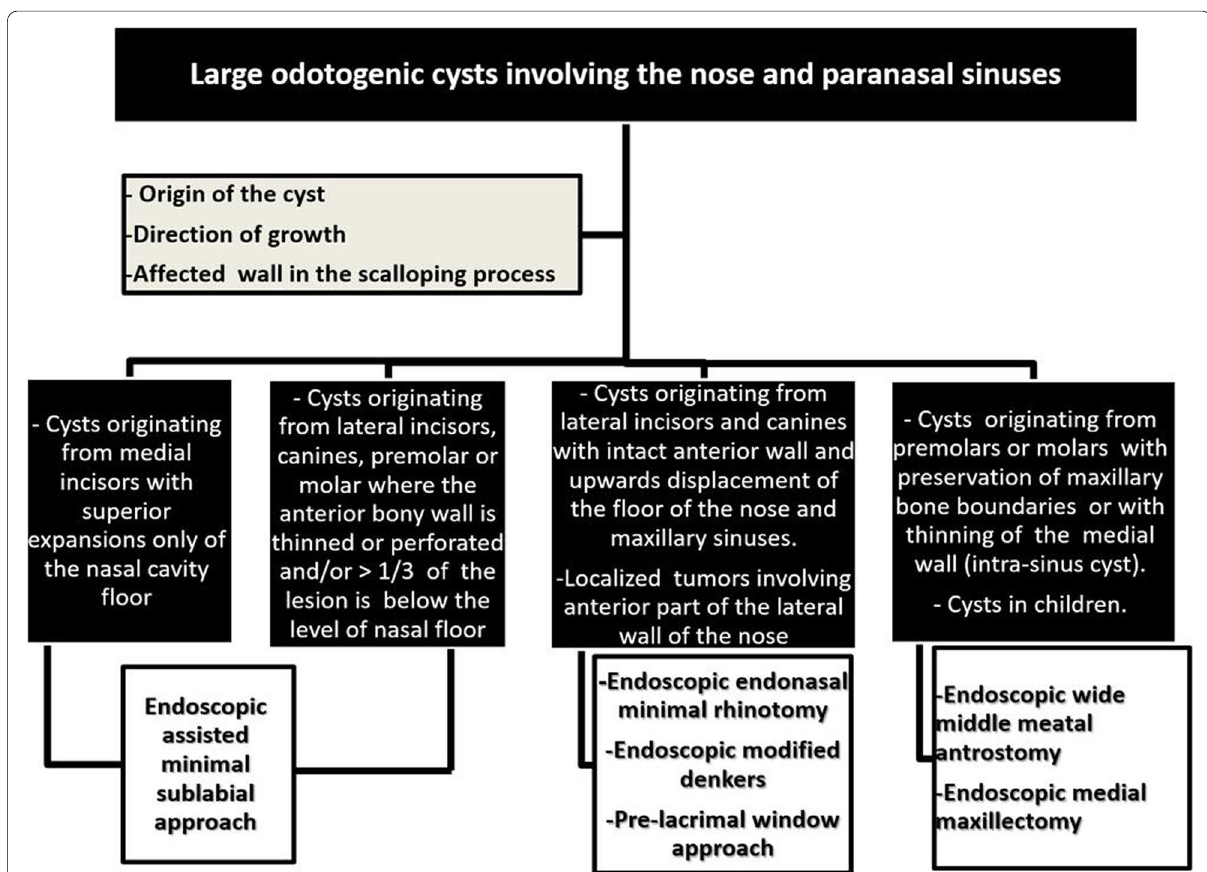
Fig. 4 Algorithm for endoscopic enucleation of large odontogenic cysts and